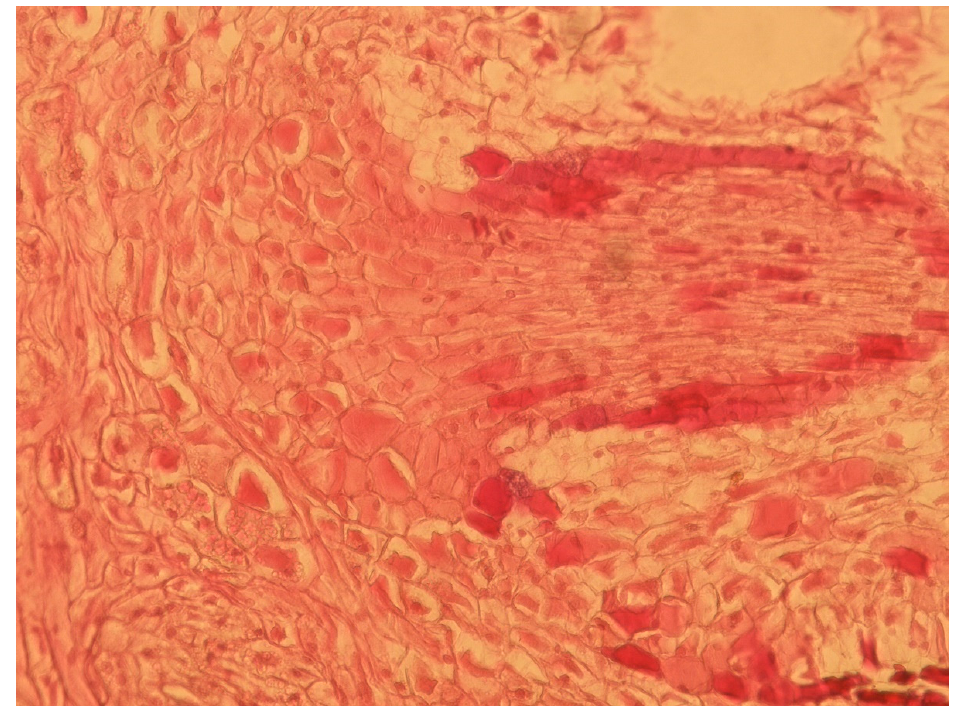
Figure 5. Root formation from calli, observed using light microscopy. Here, the callus begins to differentiate into sharp and long primordial tissues.